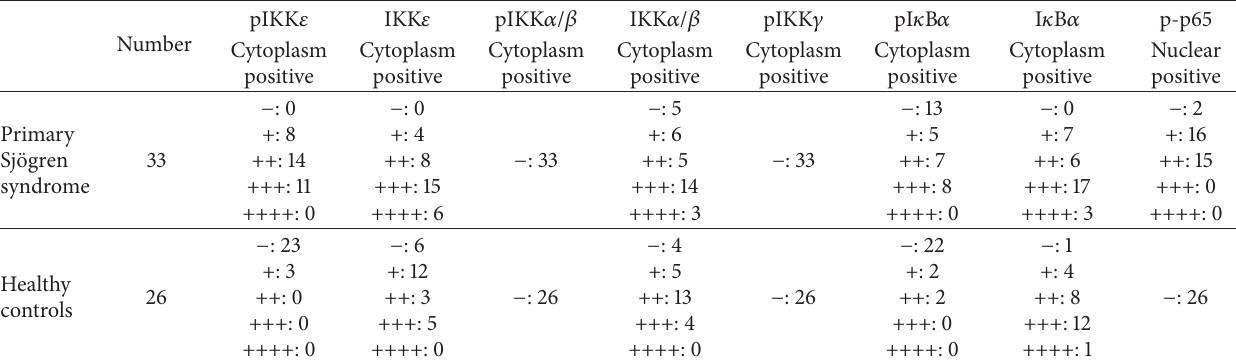
Table 2: IKK 𝛼 / 𝛽 / 𝛾 / 𝜀 expression in the MSG from pSS patients and healthy controls by immunohistochemistry.